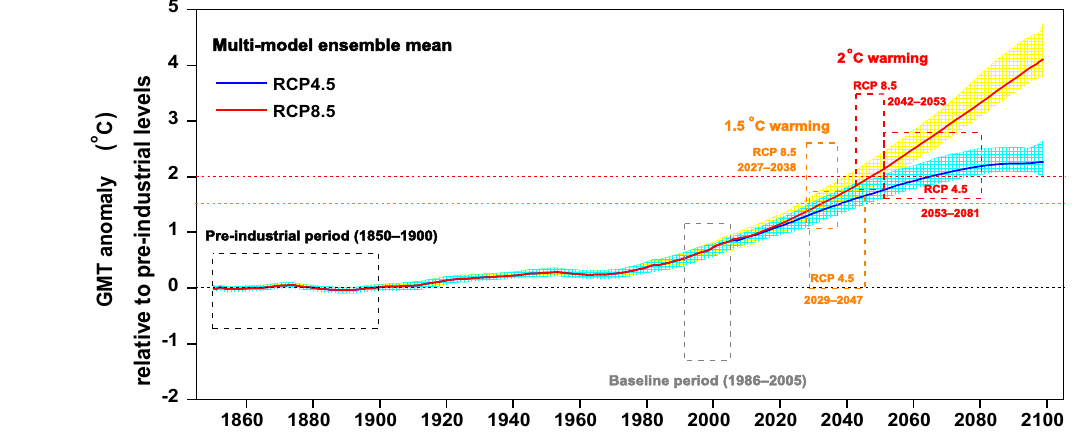
Figure 1. Definition of the baseline period and the 1.5 and 2 ◦ C warmer worlds based on CMIP5 GCM-simulated changes in global mean temperature (GMT) relative to the preindustrial levels from 1850 to 1900. The dark blue and dark yellow shadows indicate the 25th and 75th percentiles of multi-model simulated GMT for RCP4.5 and RCP8.5 scenarios, respectively. Both the multi-model ensemble mean and percentiles shown in the figure are smoothed using a moving average approach in a 20-year